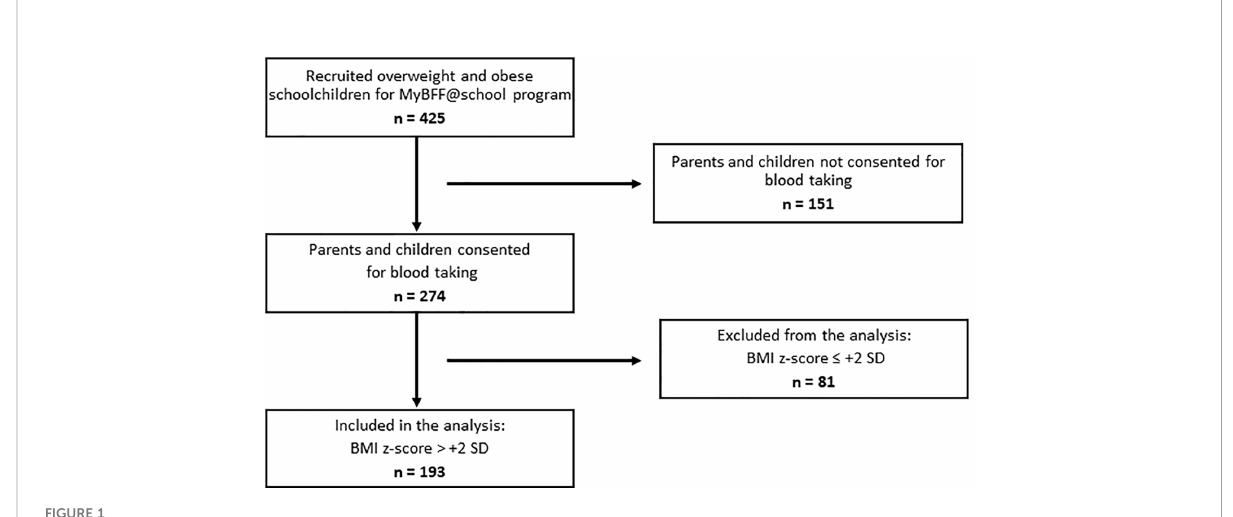
FIGURE 1 Flow chart for blood selection for MHO and MUO analysis.